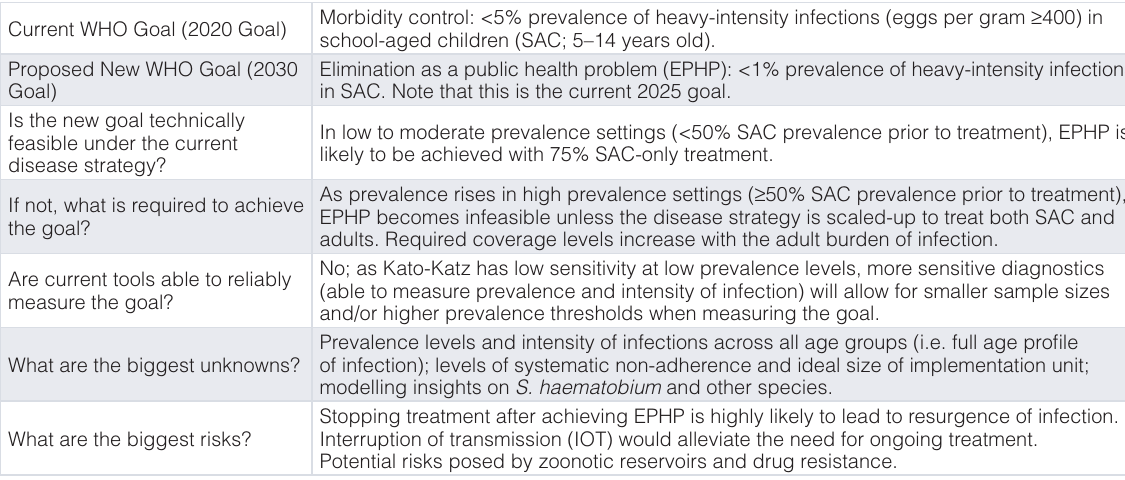
Table 1. Summary of modelling insights and challenges for reaching the WHO 2030 goal for Schistosoma mansoni